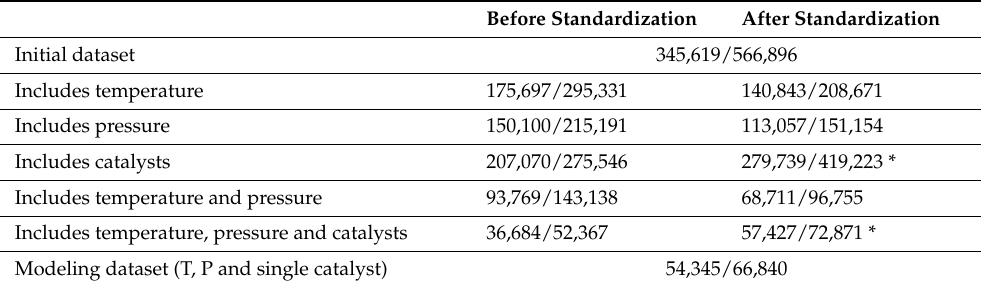
Table 2. Statistics of conditions standardization (number of